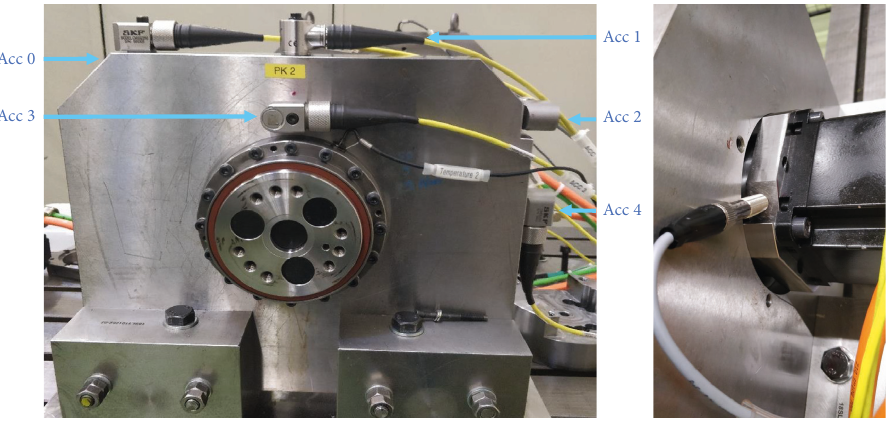
Figure 5: Vibration sensors placement. (a) Tachometer placement (b). Table 2: Test rig